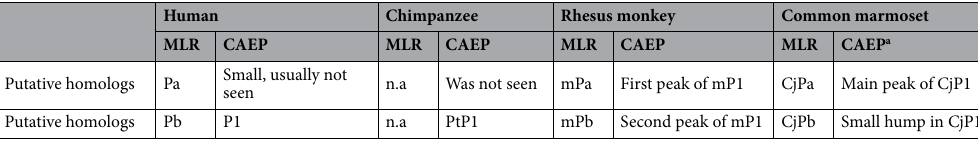
Table 2. Putative homologies of Pa/Pb (MLR) and their relationship with P1 (CAEP). n.a. information not available, to our knowledge. CAEP cortical auditory-evoked potential, MLR middle latency response. a The first positive CAEP component, referred to here as CjP1, was denoted as CjP1 in our previous study to distinguish it from the “true” CjP1, or